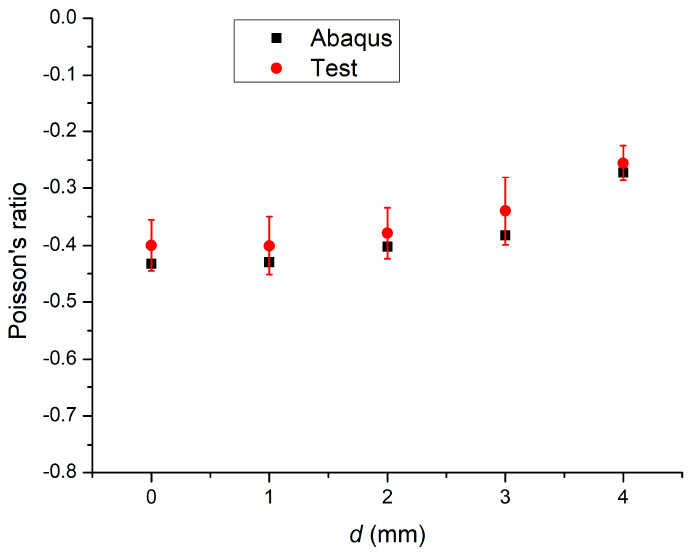
Figure 5. Poisson’s ratio in the Abaqus simulation and tensile tests.